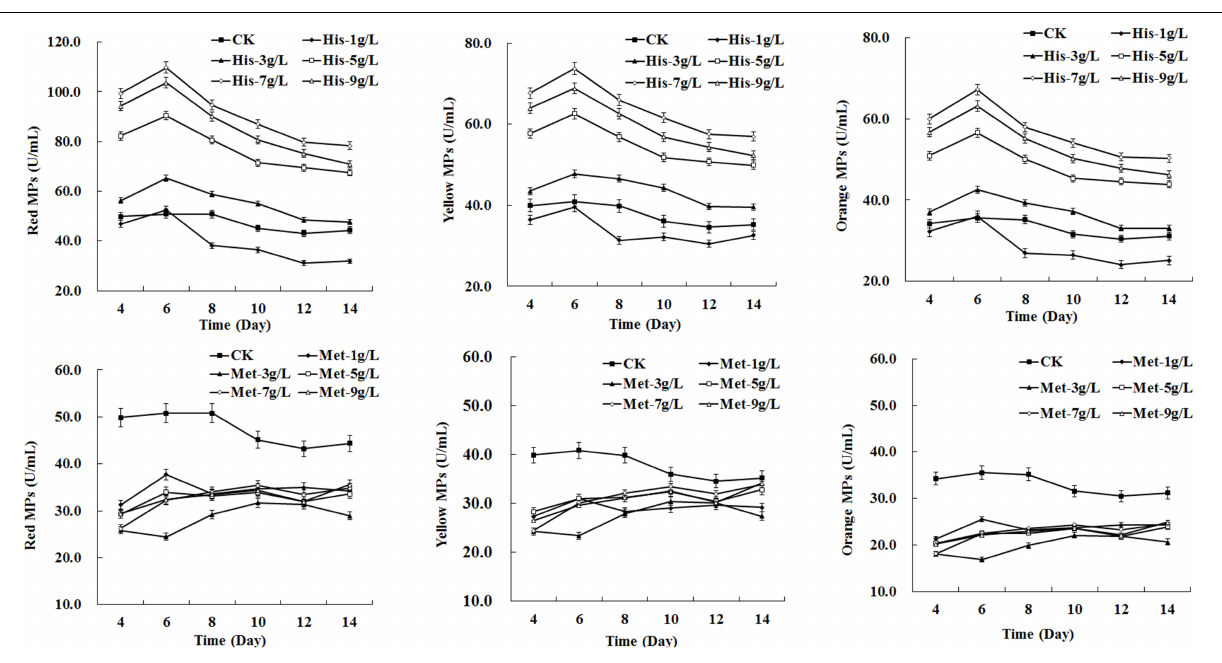
displayed an inhibiting effect on three kinds of MPs production, and the dose with significant effect was observed to be 3 g/L for MET and 5 g/L for CYS ( Figure 2 and Supplementary Figure 1